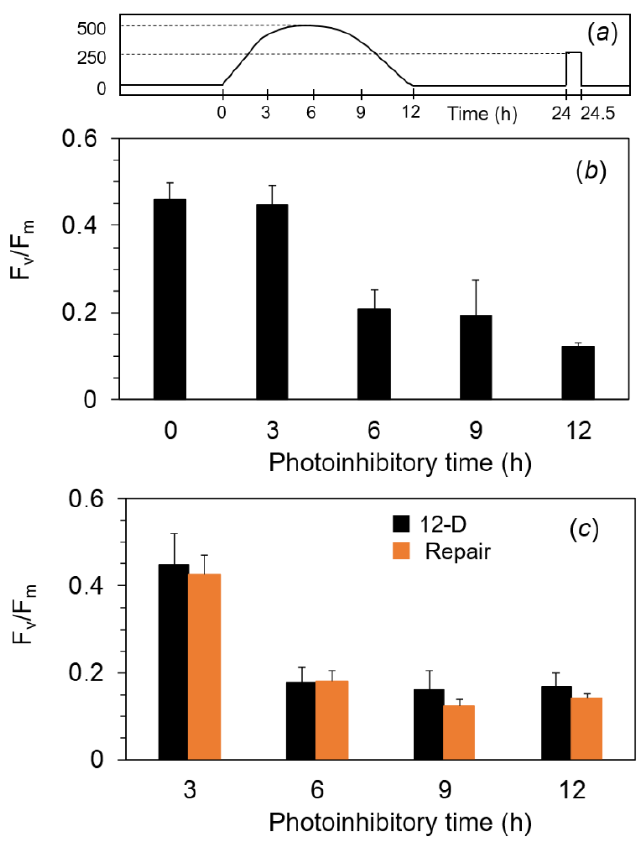
Figure 5. F v /F m in the filamentous cells of marimo after the exposure to the simulated diurnal light and the subsequent moderate light at 250 µ mol m − 2 s − 1 for 30 min at 2 ◦ C. Dark-treated cells were exposed to the diurnal light for 12 h, which was a maximum of 500 µ mol m − 2 s − 1 at 6 h from the onset, through the white LEDs at 2 ◦ C on ice ( a ). After the light treatment for each given time (3, 6, and 9 h), F v /F m was measured at 4 ◦ C after the dark treatment for 30 min ( b ) and 12 h (black bar in c ). The cells treated with the 12 h dark treatment were irradiated by the white light at 250 µ mol m − 2 s − 1 used as the repair light for 30 min at 2 ◦ C on ice, and then F v /F m was measured after the dark treatment for 30 min ( c ) (orange bar in c ). Measurements were taken in the cold room (40 Pa CO 2 , 21 kPa O 2 , at 4 ◦ C). The values represent the means ± SD ( n = 6–8). After 2 days of the simulated natural illumination, F v /F m showed a lower value of